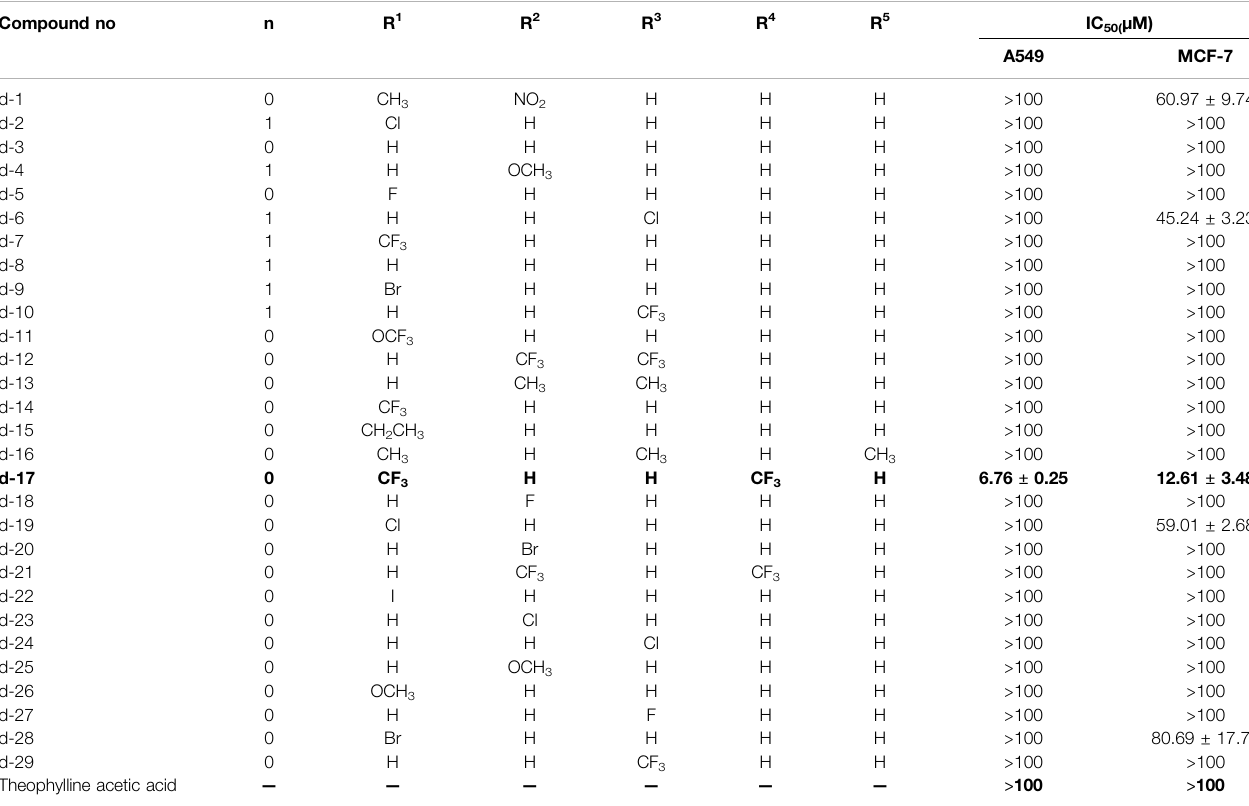
TABLE 1 | Antitumor activities of the designed compounds against two cancer cells lines in vitro . Compound